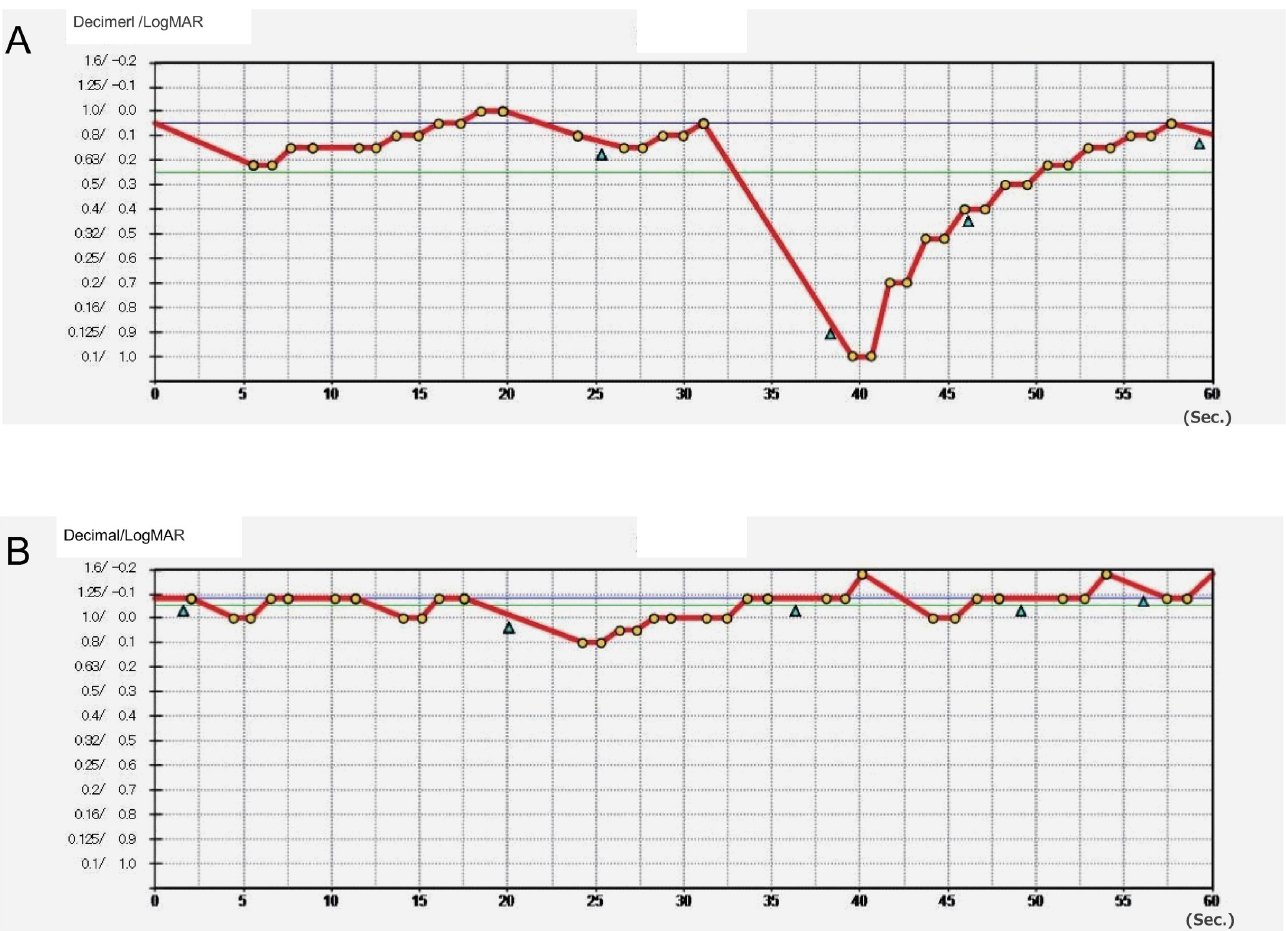
Fig 4. Functional visual acuity in representative cases with MCI and NC. (A) A 75-year-old man with an MMSE score of 30. (B) A 71-year-old man with an MMSE score of 18. MCI, mild cognitive impairment; MMSE, Mini-Mental State Examination; NC, normal cognition.